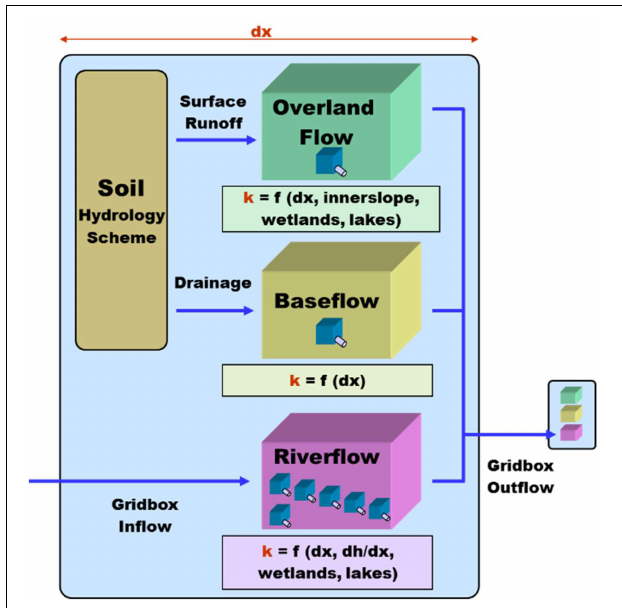
FIGURE 1 | The HD model structure. The figure was designed by S. Kotlarski (pers. comm. 2006).